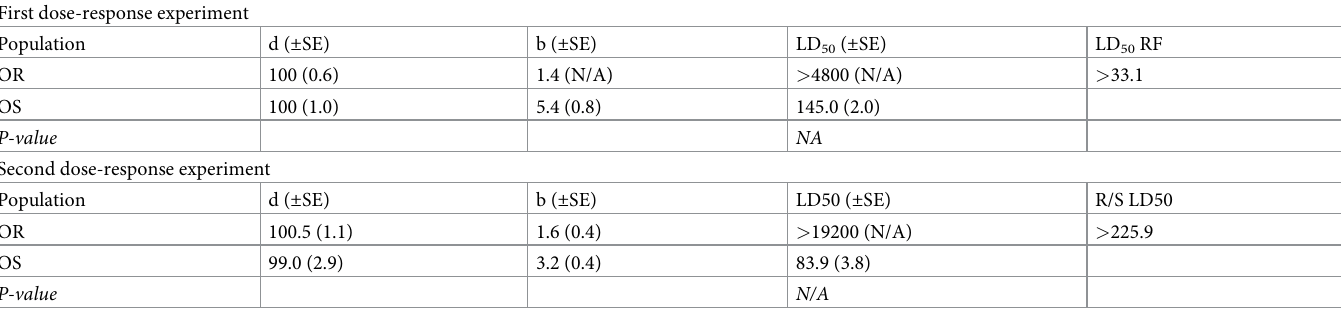
d = the upper limit, b = the slope around the LD 50 , LD 50 = the rate of herbicide (g ae ha -1 ) required to cause 50% mortality, SE = standard error LD 50 RF = resistant/susceptible factor based on LD 50 ratios. N/A = not